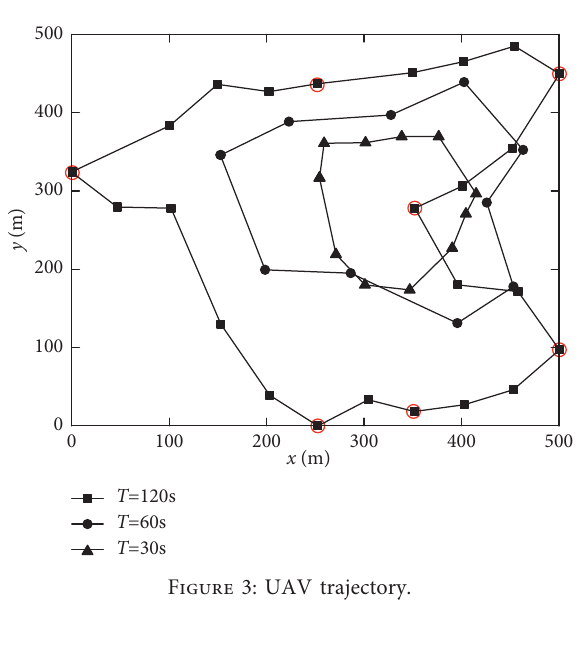
Figure 3: UAV trajectory.